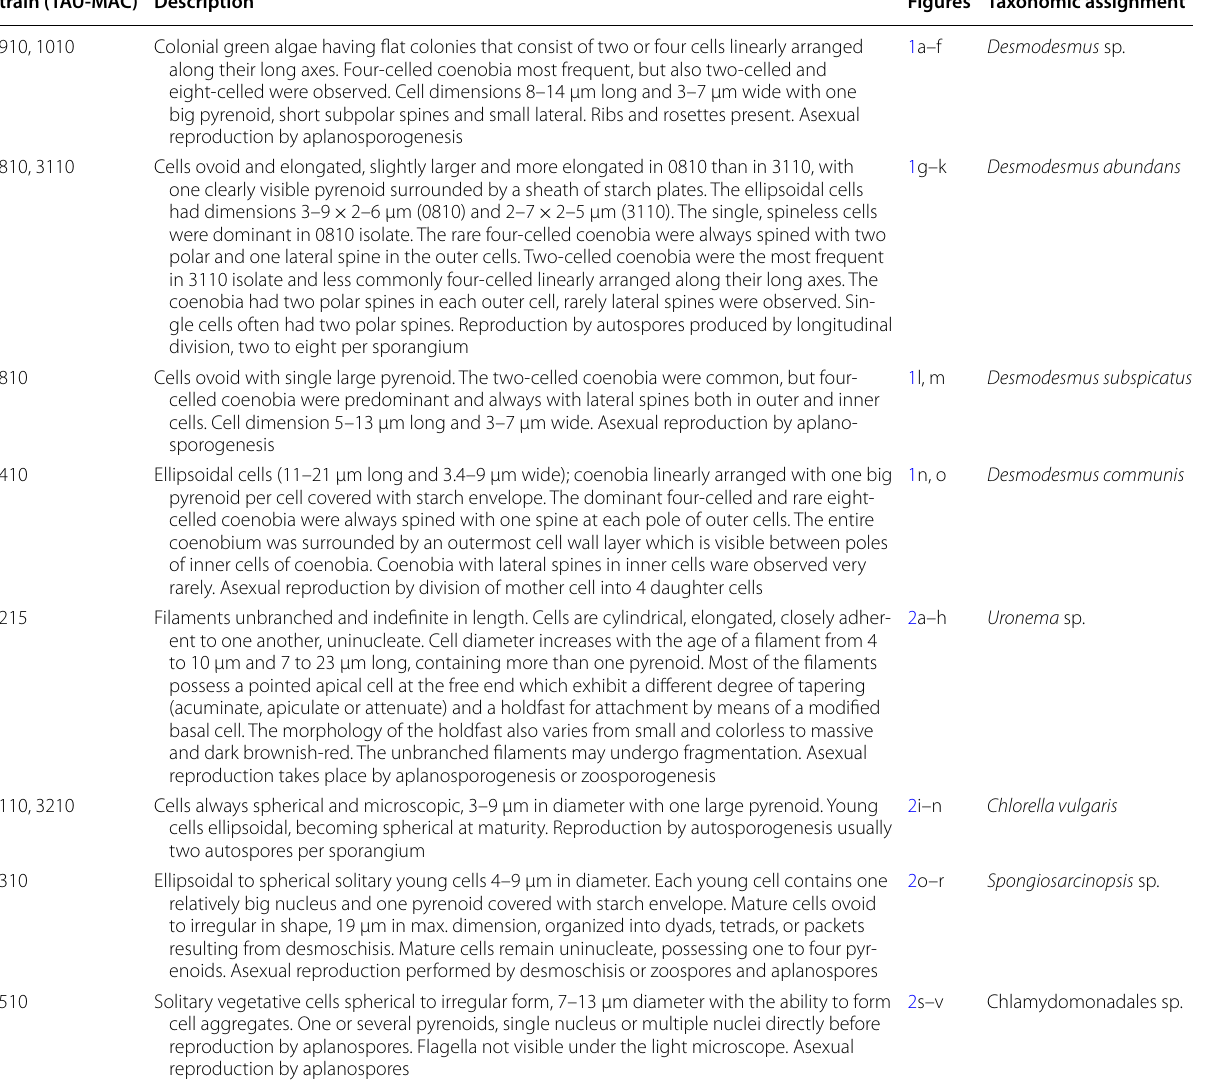
Table 2 Morphometric and morphological characteristics of the TAU-MAC strains isolated from freshwaters in Greece Strain (TAU-MAC) Description Figures Taxonomic assignment 0910, 1010 Colonial green algae having flat colonies that consist of two or four cells linearly arranged along their long axes. Four-celled coenobia most frequent, but also two-celled